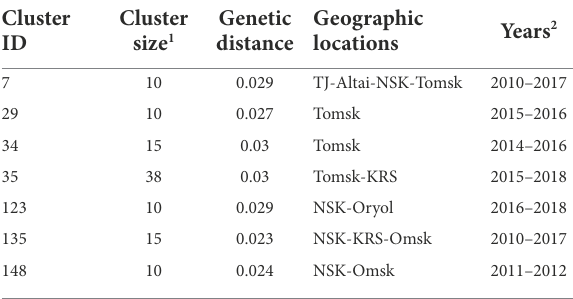
The table represents the size of transmission clusters, the maximum genetic distances between the sequences within the cluster, the region where the sequences were collected, and sequences collection dates. Genetic clusters were identified using Cluster Picker v1.2.3 with the maximum genetic distance of 0.03 and the branch support value ≥ 90. 1 Cluster size indicates the number of sequences in the transmission cluster. 2 The period when the samples within the cluster were